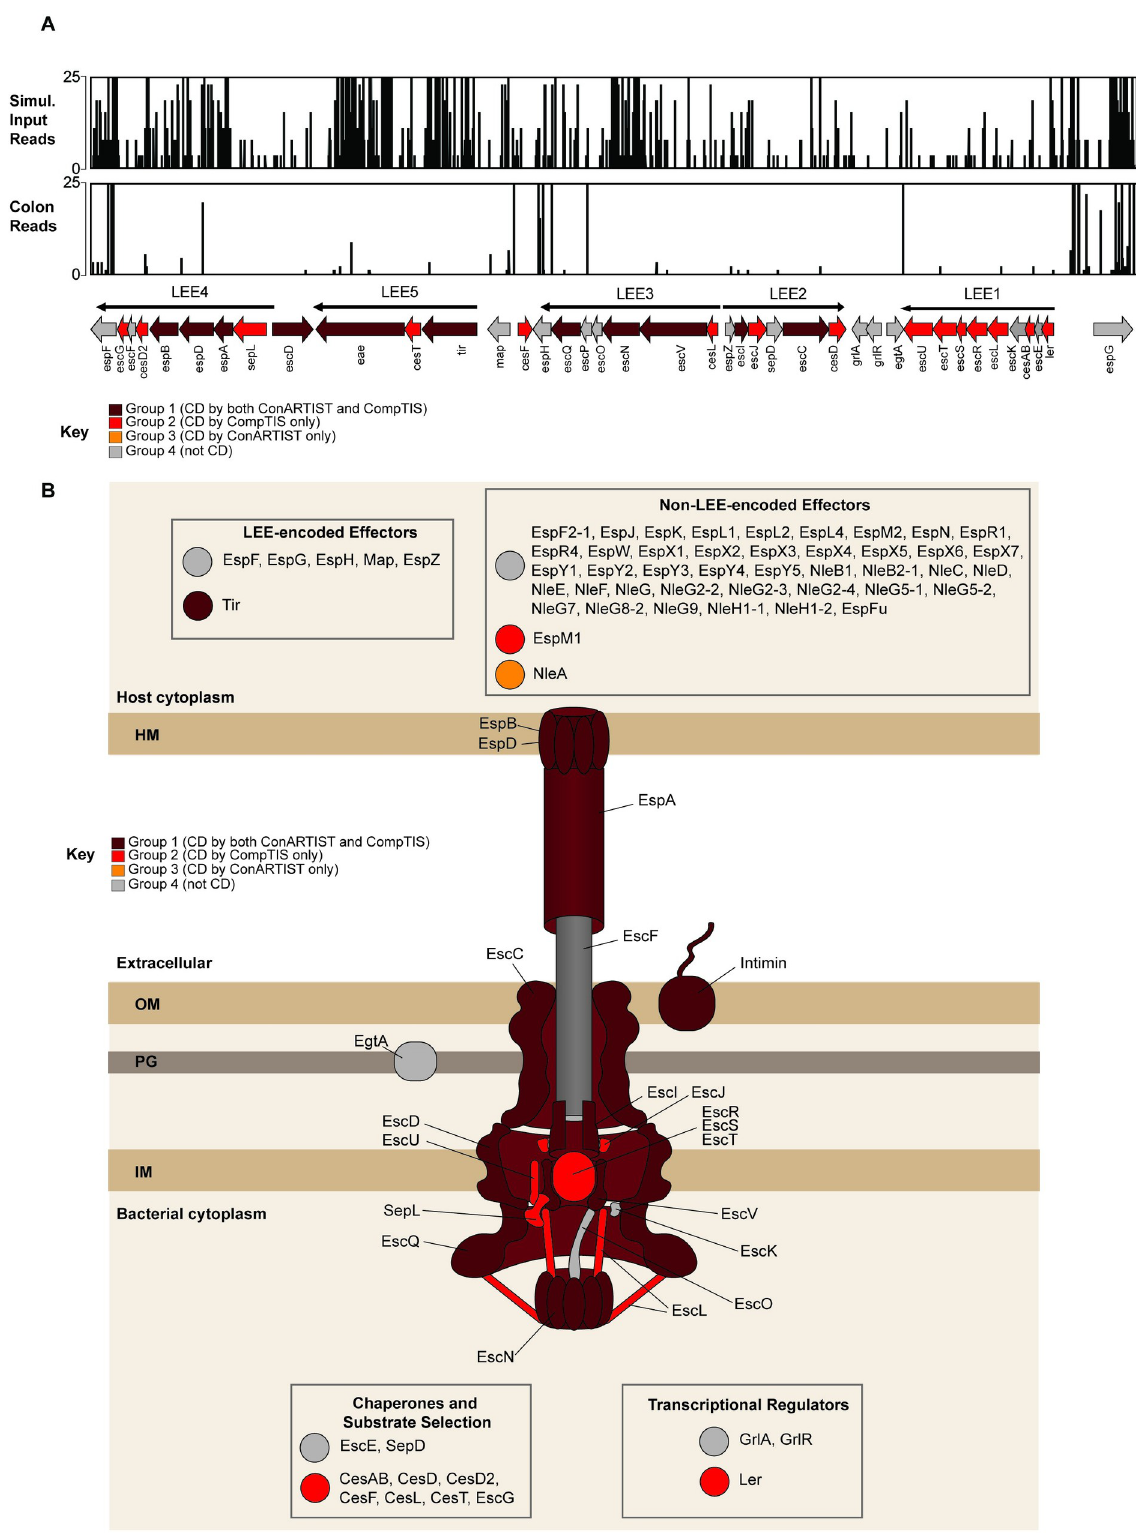
Fig 4. Con-ARTIST and CompTIS-based classification of LEE genes and T3SS effectors. (A) Artemis plots of reads in the LEE pathogenicity island in the control-simulated inoculum library (top) and a representative library recovered from the rabbit colon (middle). The genes in